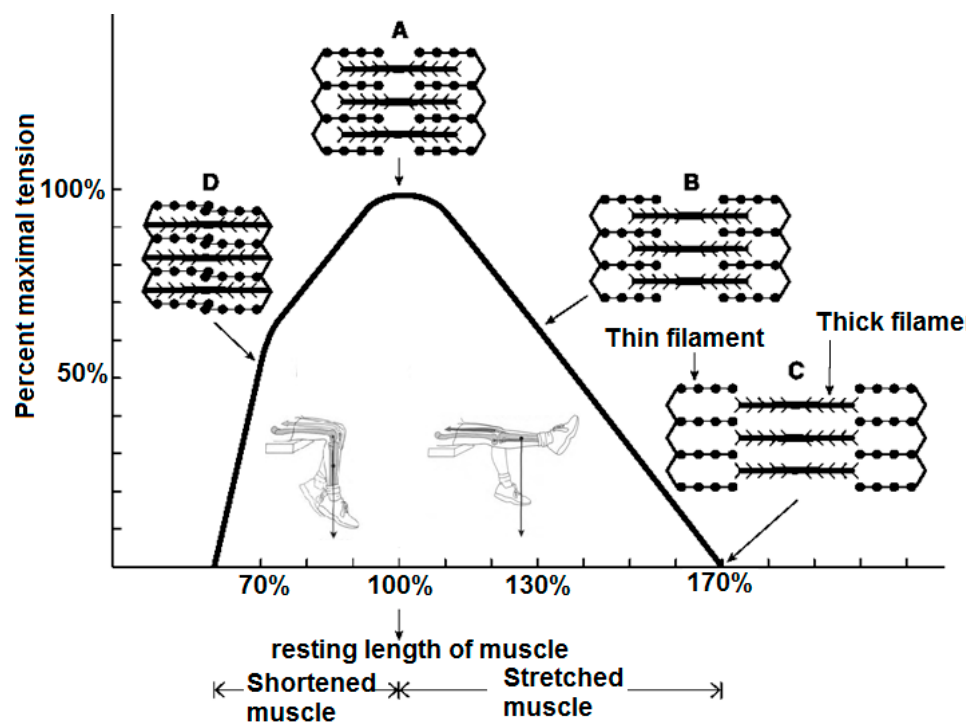
Figure 2. The relationship between the tension and length of a muscle.